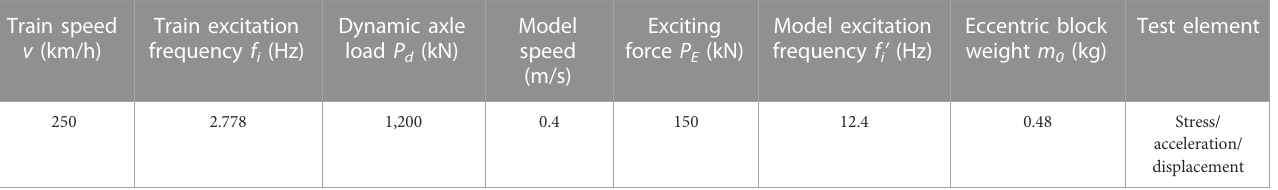
TABLE 4 Design condition of the model